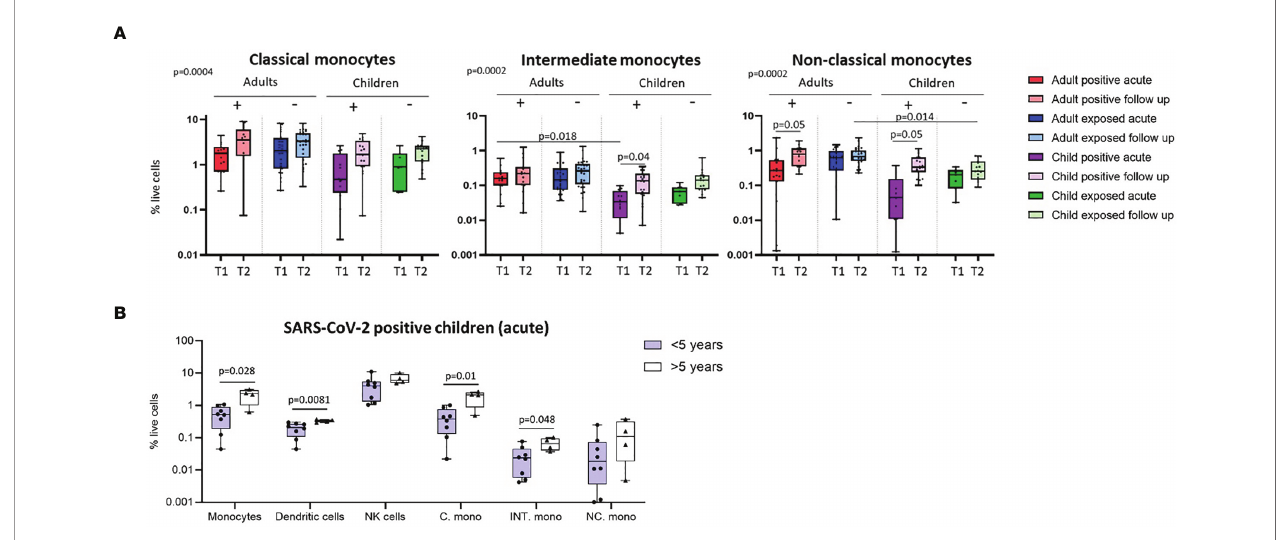
FIGURE 2 | Innate cell responses in children and adults. (A) Classical, intermediate and non-classical monocyte proportions from SARS-CoV-2 positive participants (n=12 child acute, n=20 child follow up, n=15 adult acute, n=15 adult follow up) and SARS-CoV-2 exposed participants (n=7 child acute, n=16 child follow up, n=24 adult acute, n=32 adult follow up), T1 – acute samples, T2 – follow up samples. (B) Innate cell pro fi les in SARS-CoV-2 positive children during infection, strati fi ed by age [under 5 years (n=8, median age 1.5 years), over 5 years (n=4, median age 10.5 years)]. P-values by Kruskal-Wallis rank sum test and Dunn ’ s multiple comparison testing (A) and by Mann-Whitney U test (B) . FDR-adjusted P-values are reported. Boxplots show the medians, the 1 st and 3 rd quartile as well as the smallest and largest values as